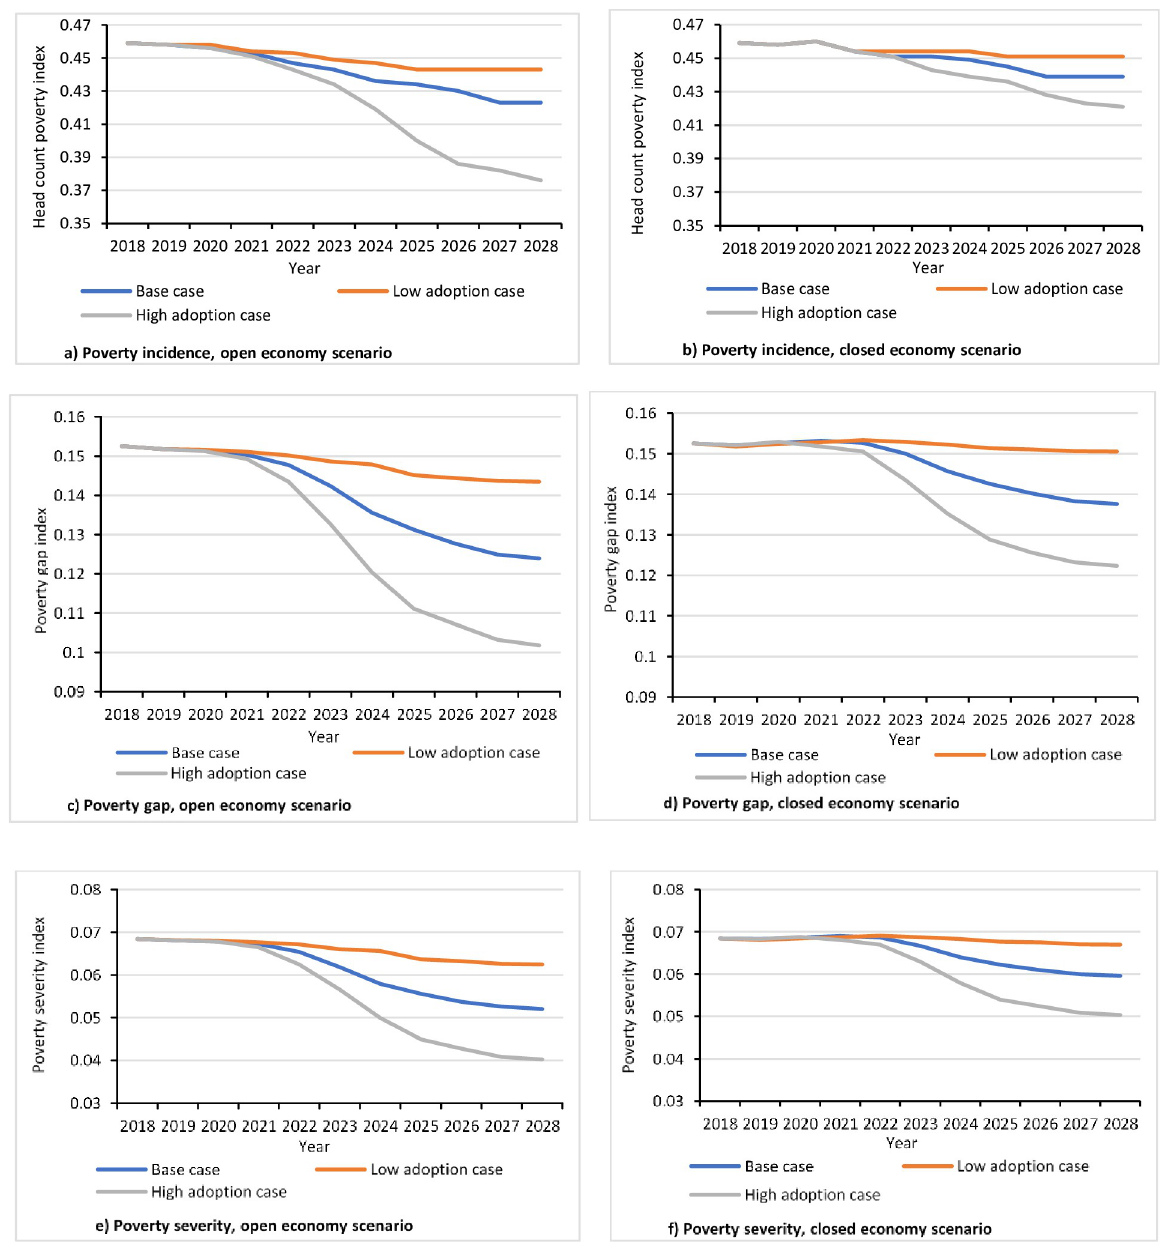
Fig 8. Sensitivity of poverty indices to changes in adoption